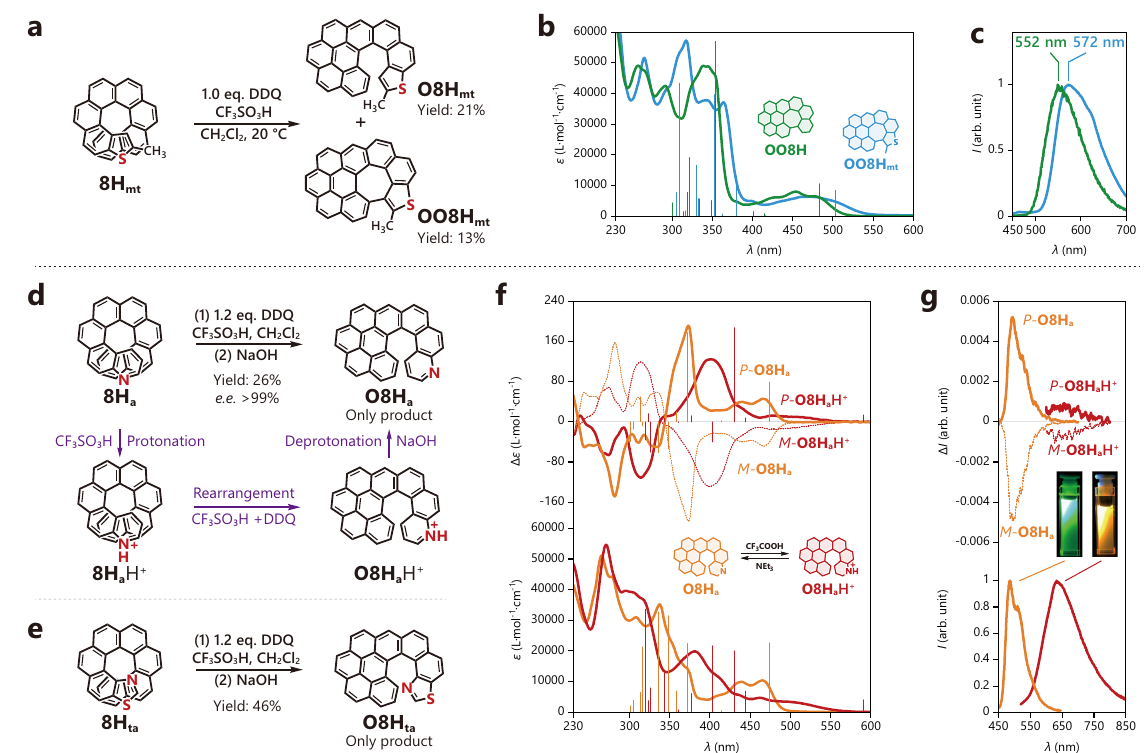
Fig. 5 Oxidative cyclo-rearrangement of hetero-atom-doped helicenes. a Synthesis of sulfur-doped O8H mt via oxidative cyclo-rearrangement of 8H mt , and further cyclization to OO8H mt . b UV-vis absorption and c fl uorescence spectra of OO8H mt with comparison to OO8H (in CH 2 Cl 2 , c = 2.0 × 10 − 5 mol L − 1 ). d Synthesis of nitrogen-doped O8H a via oxidative cyclo-rearrangement of 8H a . e Synthesis of sulfur-doped and nitrogen-doped O8H ta via oxidative cyclo-rearrangement of 8H ta . f UV-vis absorption (bottom) and electronic circular dichroism (ECD) spectra (top) of O8H a and O8H a H + (in CH 2 Cl 2 , c = 2.0 × 10 − 5 mol L − 1 ). g Fluorescence (bottom) and circularly polarized luminescence (CPL) spectra (top) of O8H a and O8H a H + (in CH 2 Cl 2 , c = 2.0 × 10 − 5 mol L − 1 ). The inset photographs are recorded under irradiation at 365 nm. All calculated excitation energies and oscillator/rotatory strengths (velocity form) are displayed as sticks (the fi rst 10